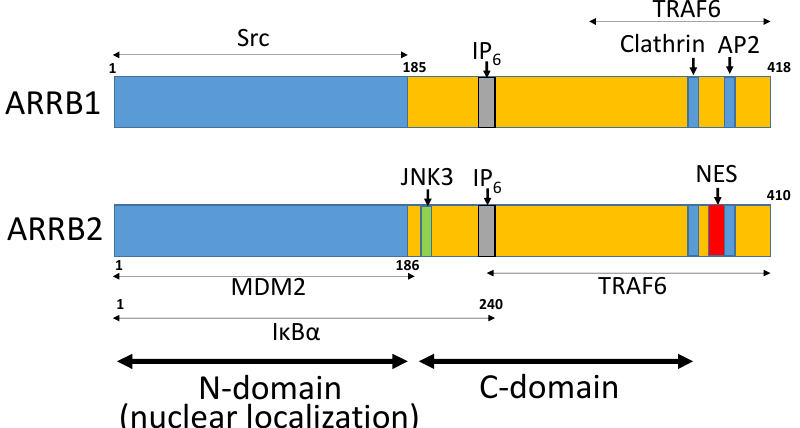
Figure 1. The structure of β -arrestins (ARRBs). Nuclear localization is mediated by the N domain of ARRB1 and ARRB2. A nuclear export signal is located in the C-terminus of ARRB2. The binding sites of various signaling molecules are located in both N and C domains (Figure adapted from Ma and Pei [1]).